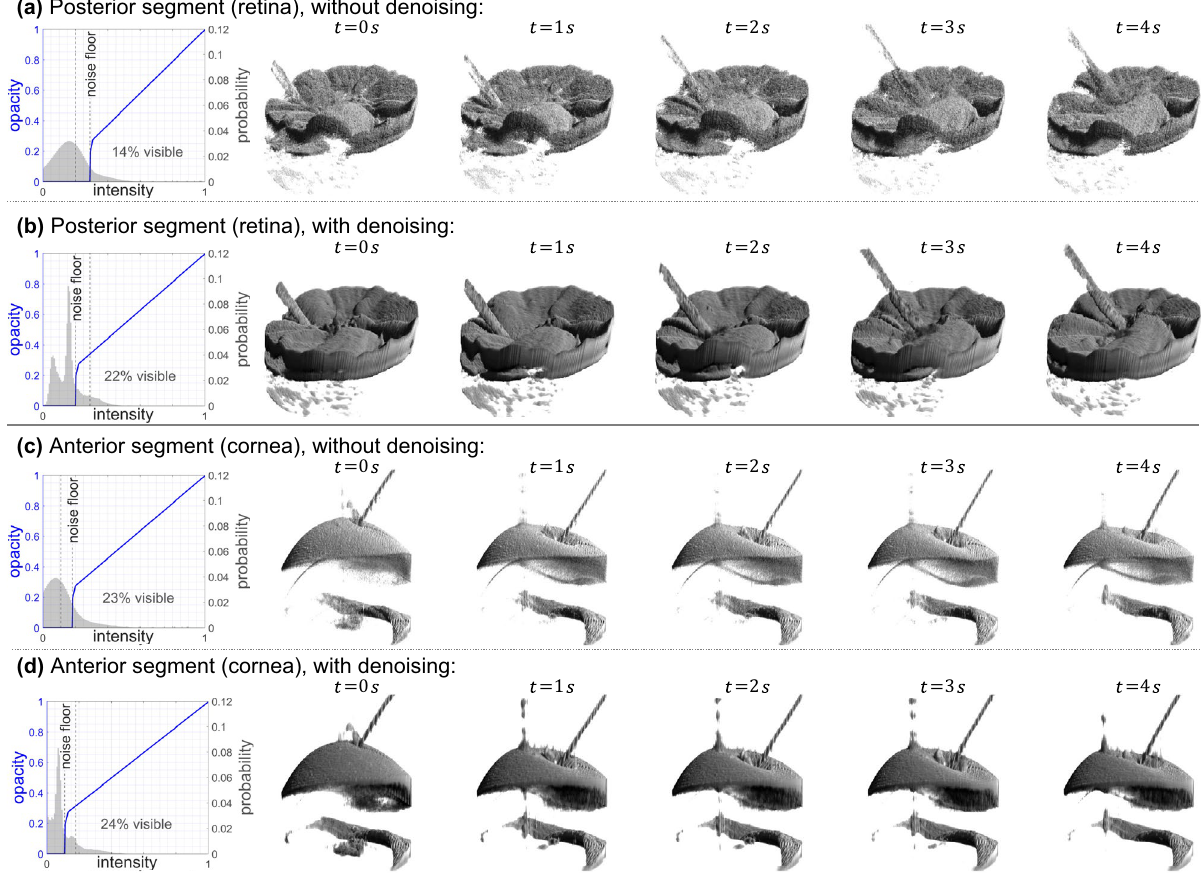
Figure 6. Frames showing volumetric renderings without and with denoising together with the respective rendering intensity-opacity transfer functions (blue curves) and gray value histograms. Each row shows a separate acquisition with different settings. The effect during real, dynamic acquisitions is best viewed in Supplementary Videos 2–4, which contain more examples as well as renderings using identical transfer